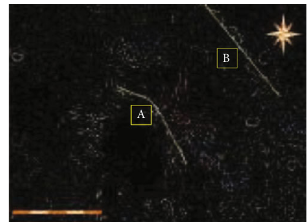
Figure 11: Geomorphological image of data processing band 4 in gray-scale format.